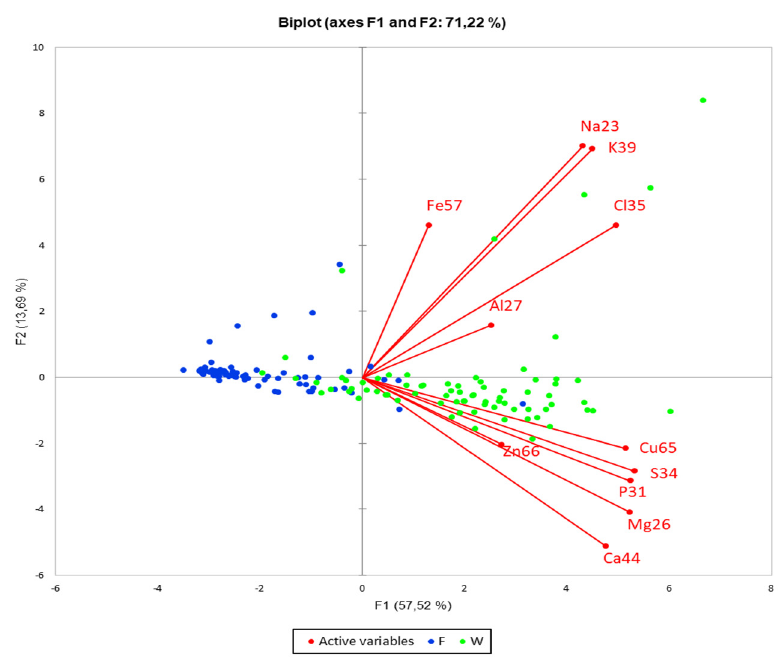
Figure 3. Biplot of averaged isotopic signal intensities in F1/F2 dimension constructed from the data of all prostate glands (n = 70), divided into rich in fat (F) and rich in water (W) parts. Average relative signal intensities from both ROIs (“W” ROI and “F” ROI) of each sample were included in further calculations. Values from the same condition group (for example: Zn-supplemented with cancer cells) were treated as biological replicates and all samples (n = 70) were subjected to the statistical analysis. Analysis of variance (ANOVA) tests were performed, preceded by checking normal distribution by Shapiro–Wilk test and homoscedasticity by Levene’s test. In the case of statistically significant differences ( p - value below 0.05), Tukey’s post hoc test was performed in order to find which means were significantly different from each other. The condition group’s results were compared for each element in order to check if cancer cell implantation and/or diet supplementation influenced the elemental content in specific regions of the prostate gland. Only in the case of Zn, in “W” ROI, were statistically significant differences noticed, as indicated in Figure 4A. Zinc contents in healthy prostate glands are very high, because this element is required for important prostatic functions [72]. The error bars in Figure 4 represent the differences between biological, not technical, replicates; thus, relatively high values are understandable. Standard deviation values in the case of zinc were higher than in the case of other elements, which was also observed by other authors [15] and in our previous experiment [68]. This inter-group inhomogeneity can be explained by zinc accu- mulation by prostate gland cells and its metabolic involvement in prostate carcinogenesis [73]. Zn contents in the prostate gland are characterized by very high individual variabil- ity [15]. Dietary supplementation with calcium, iron, copper, and selenium could weaken the absorption of zinc at the first stage in the intestinal wall, which may partially explain the effect of dietary supplementation, without such an effect for a non-supplemented, i.e., standard diet. In addition, the implantation of prostate cancer cells could exacerbate zinc deficits in the gland. In men with adenocarcinoma of the prostate, the concentration of zinc in the prostate tissue decreases significantly compared with the surrounding healthy tissues [74]. It has been noticed that the degree of malignancy of prostate cancer may be conditioned by deteriorations in the zinc content. Already in the early stage of carcino- genesis, the concentration of this microelement decreases, and with the development of a tumor, it is further reduced [74,75]. The risk of DNA damage increases, and this leads to